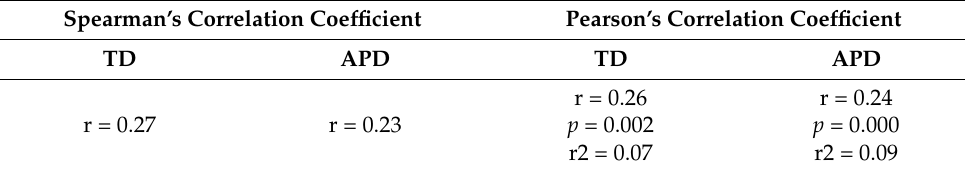
Table 7. Correlations between the results of the FPT and PDT for the TD and APD groups. Spearman’s Correlation Coefficient Pearson’s Correlation